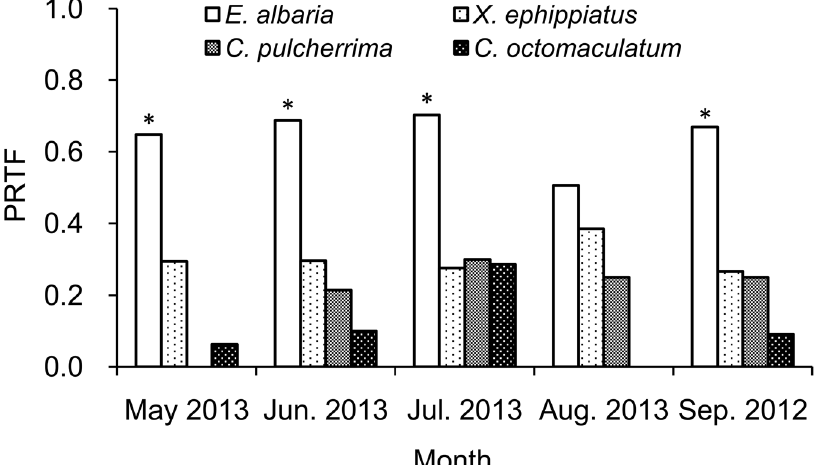
Figure 3. The PRTF (positive rates of target fragment) in spiders gut during the months when E . vitis was abundant. * In figure indicate significant difference in P < 0.05 level between E . albaria and any other species. The same below.